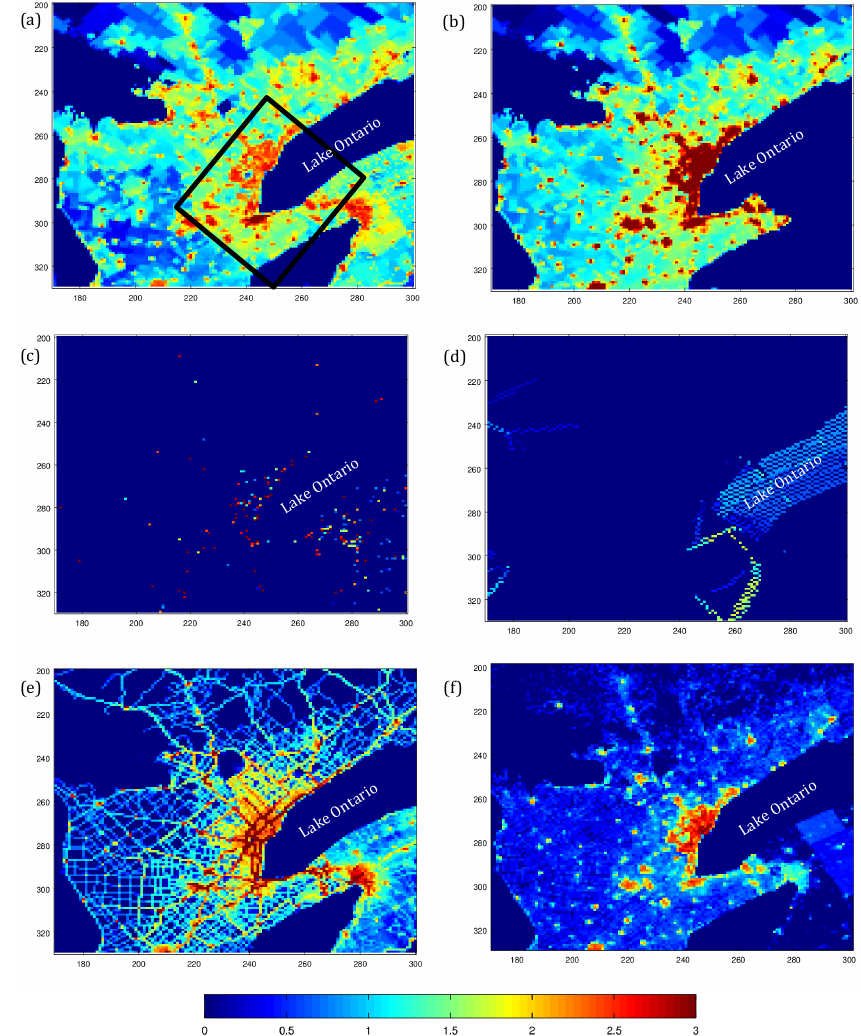
Figure 2. Anthropogenic CO 2 emissions for a weekday in February 2010 in Southern Ontario. Emissions are estimated by the SOCE inventory for the (a) area sector, (b) sum of the residential and commercial sectors, (c) point sector, (d) marine sector, (e) on-road sector, and (f) off-road sector. Unit: log 10 (gCO 2 sgrid cell − 1